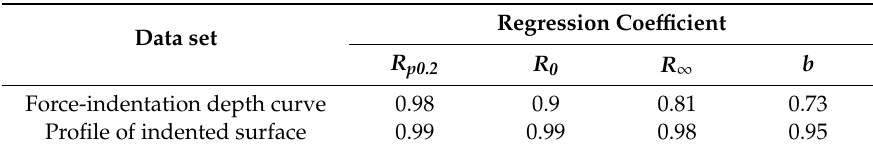
Table 6. Regression coe ffi cients obtained by comparing the desired outputs and outputs of the trained